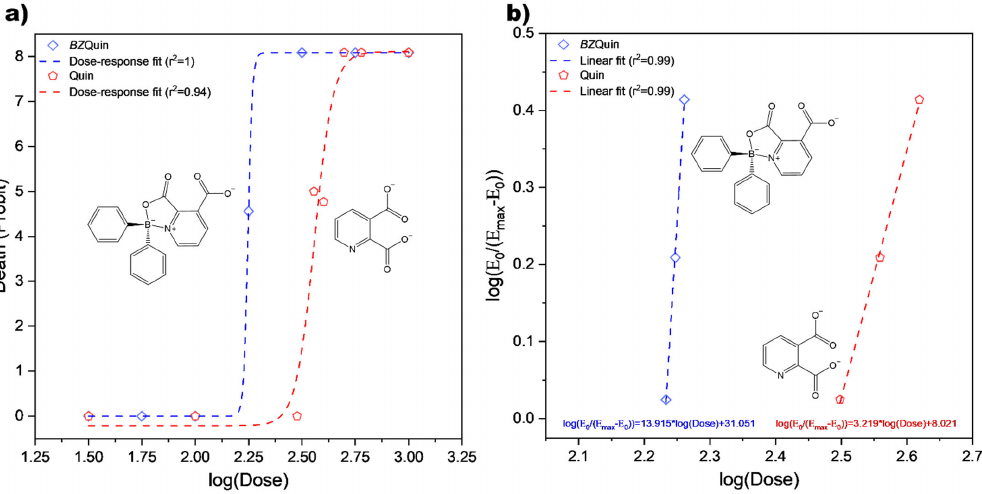
Figure 7. Acute toxicity evaluation. ( a ) BZQuin and Quin dose–response curves. ( b ) BZQuin and Quin data fitted to linearized Hill equation.